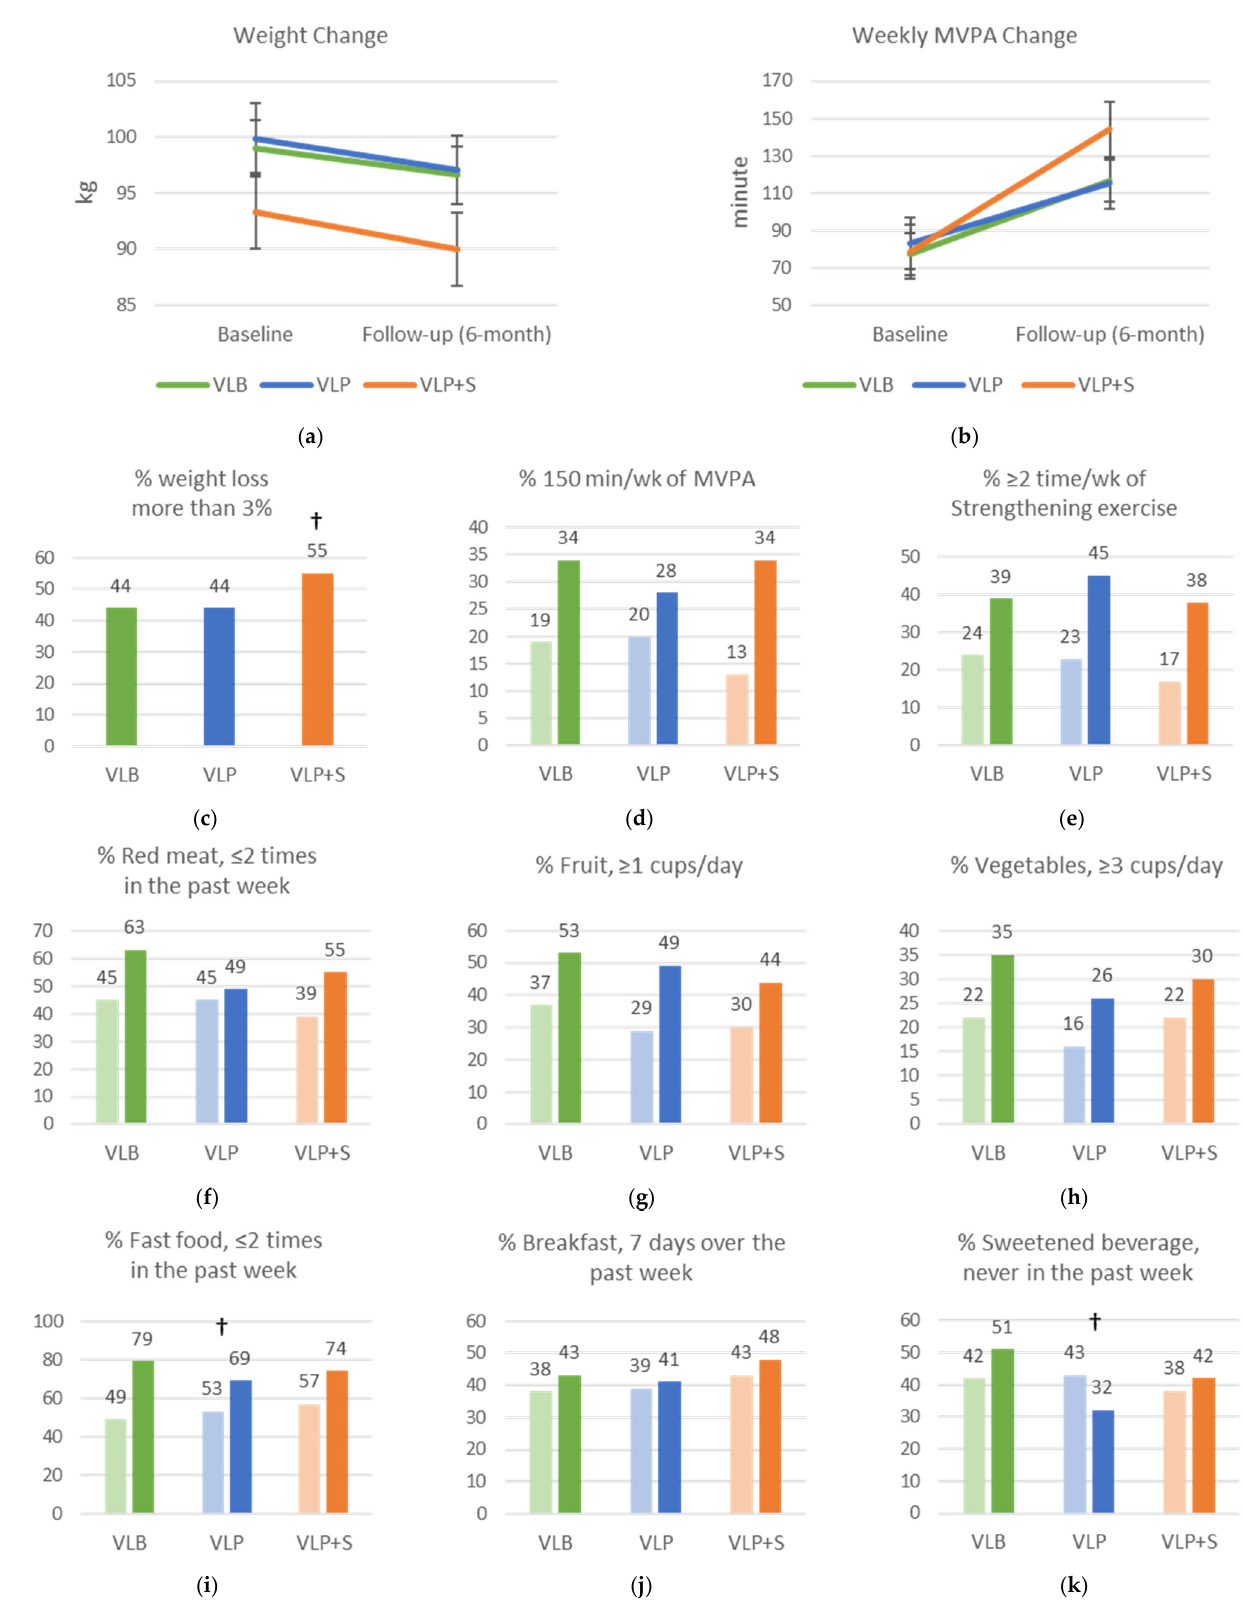
Figure 2. Changes in weight, physical activity, and dietary intake among intervention groups be- tween baseline and follow-up (6-month). ( a ) Mean weight change; ( b ) mean weekly moderate-to- vigorous physical activity (MVPA) change; ( c ) percentage who lost more than 3% of their weight; ( d ) percentage who performed 150 min/week of MVPA; ( e ) percentage who performed two or more sessions per week of strengthening exercise; ( f ) percentage who consumed red meat two or fewer times in the past week; ( g ) percentage who consumed one or more cups of fruit per day; ( h ) percent- age who consumed three or more cups of vegetables per day; ( i ) percentage who consumed fast food two or fewer times in the past week; ( j ) percentage who ate breakfast every day in the past week; ( k ) percentage who drank no sweetened beverages in the past week; VLB = Vibrant Lives Basic; VLP = Vibrant Lives Plus; VLP + S = Vibrant Lives Plus with Support; ( a , b ) repeated-measure mixed models; ( c ) logistic regression; ( d – k ) repeated measure logistic regressions; except for break- fast consumption, all had significant time differences ( p < 0.05). † Significant group differences com- pared to VLB arm ( p < 0.05). The weekly average numbers of daily active minutes and steps for the VLP and VLP + S groups ( n = 175) are given in Figure 3. Overall, the average number of daily active minutes was 20 min (SD = 23.1; VLP = 17 min ± 18.9; VLP + S = 23 min ± 25.7), and the average number of daily steps was 8030 (SD = 2939.9; VLP = 7807 steps ± 2794.1; VLP + S = 8212 steps ± 3042.2). There were significant differences in daily active minutes ( β = 6.72; SE = 3.06; p = 0.028) and daily steps ( β = 969.40; SE = 390.44; p = 0.013) between the VLP and VLP + S groups. The linear rate of daily active minutes was significant for the VLP group ( β = 0.15; SE = 0.06; p = 0.007), but not for the VLP + S group ( β = 0.02; SE = 0.07; p = 0.790). The linear rate of the daily number of steps was not significant for the VLP group ( β = 15.57; SE = 8.17; p = 0.057) or for the VLP + S group ( β = − 3.38; SE = 8.03; p = 0.673).